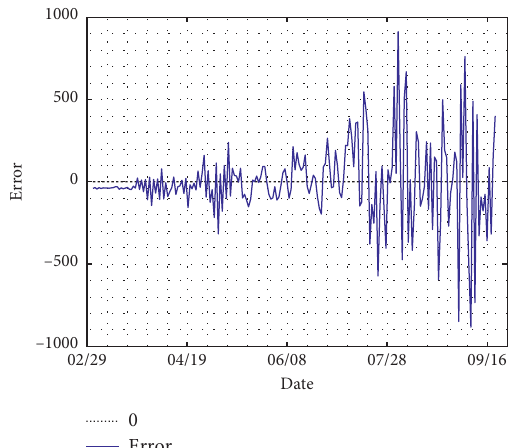
Figure 16: The fitting error of India with a mean absolute error of 154.